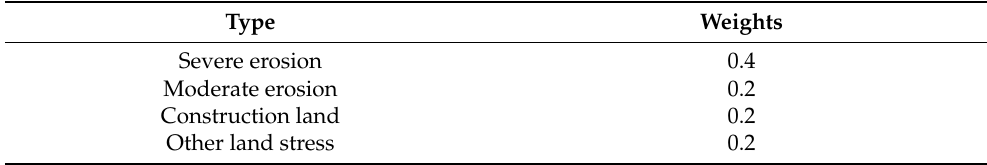
Table 5. The weight of Land-Stress